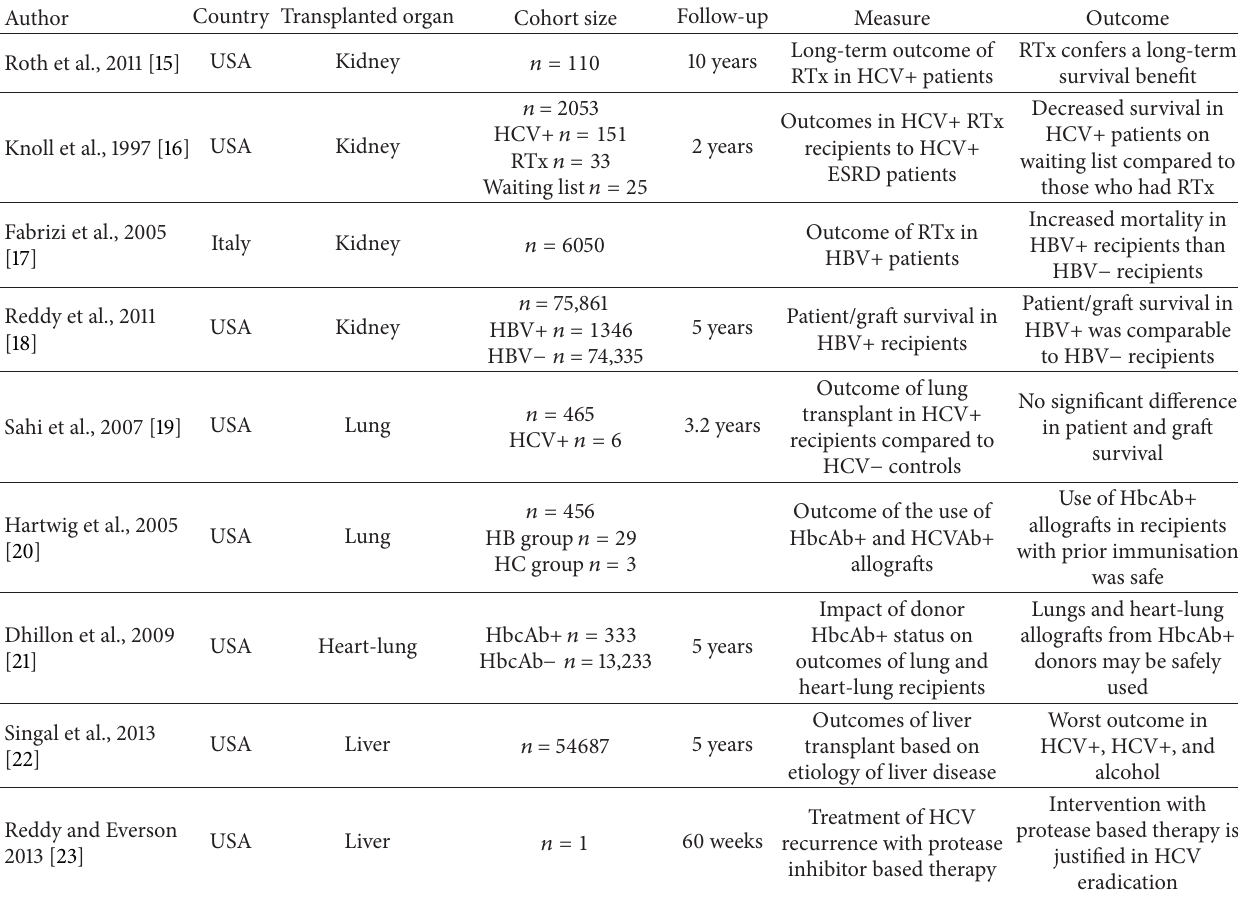
Table 2: Studies correlating HBV/HCV infection and clinical outcomes in other solid organ transplantation